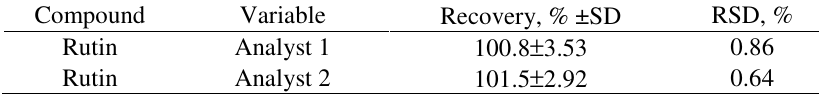
Table 3. Ruggedness of the method (n=6)